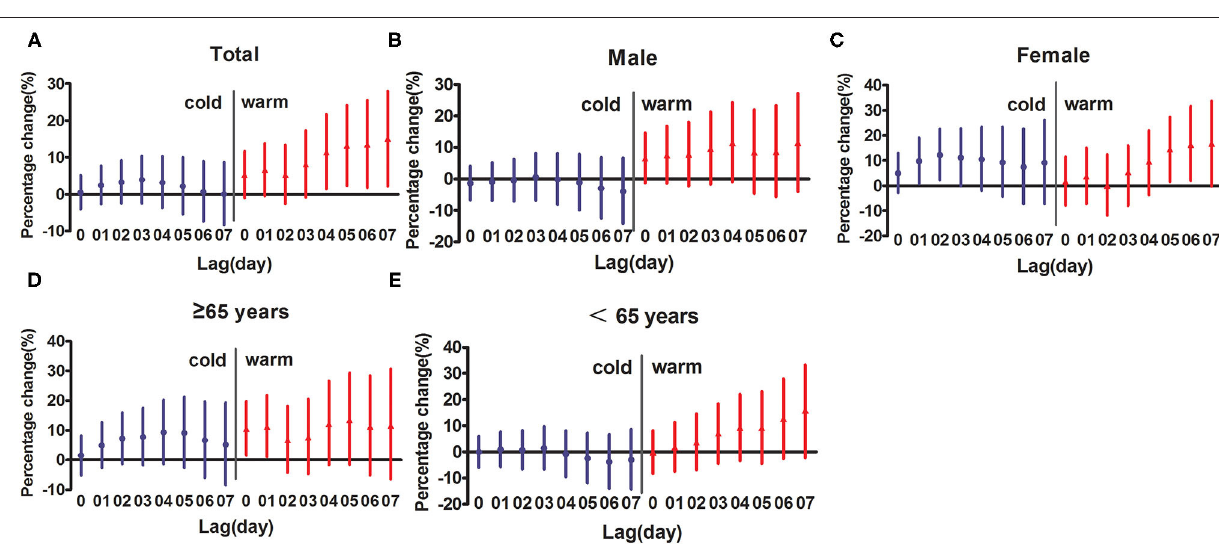
FIGURE 2 | Percentage change (95% CI) of inpatient visits per 10 µ g/m 3 increase in concentrations of SO 2 for different lag days in different seasons. (A) represents total people; (B) represents male; (C) represents female; (D) represents the elderly people ( ≥ 65 years); (E) represents younger people ( < 65